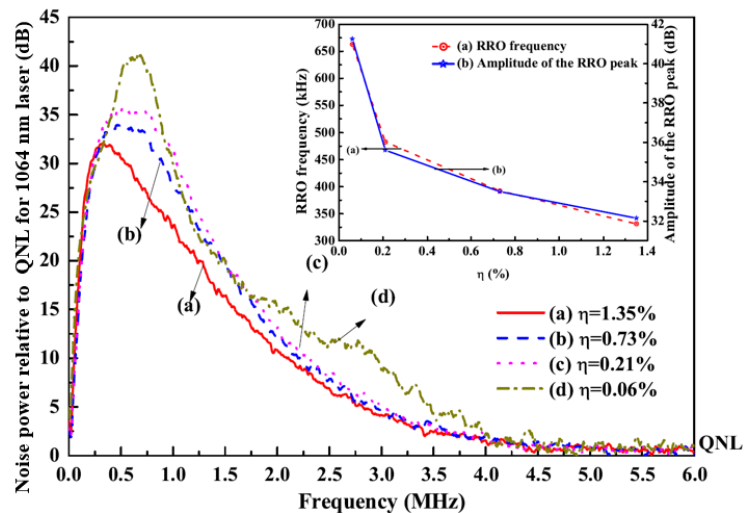
Figure 19. Intensity noise spectrum of 1064 nm laser with different nonlinear conversion coeffi- cients [31]. Reprinted with permission from [31] c (cid:13) The Optical Society.